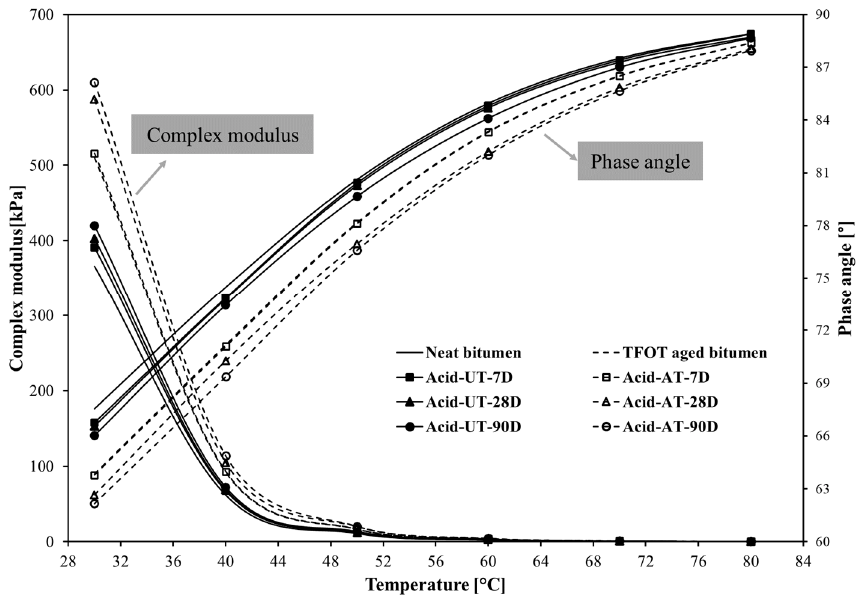
Figure 6. The complex modulus and phase angle of the bitumen at high temperature after acid rain exposure (30–80 °C).